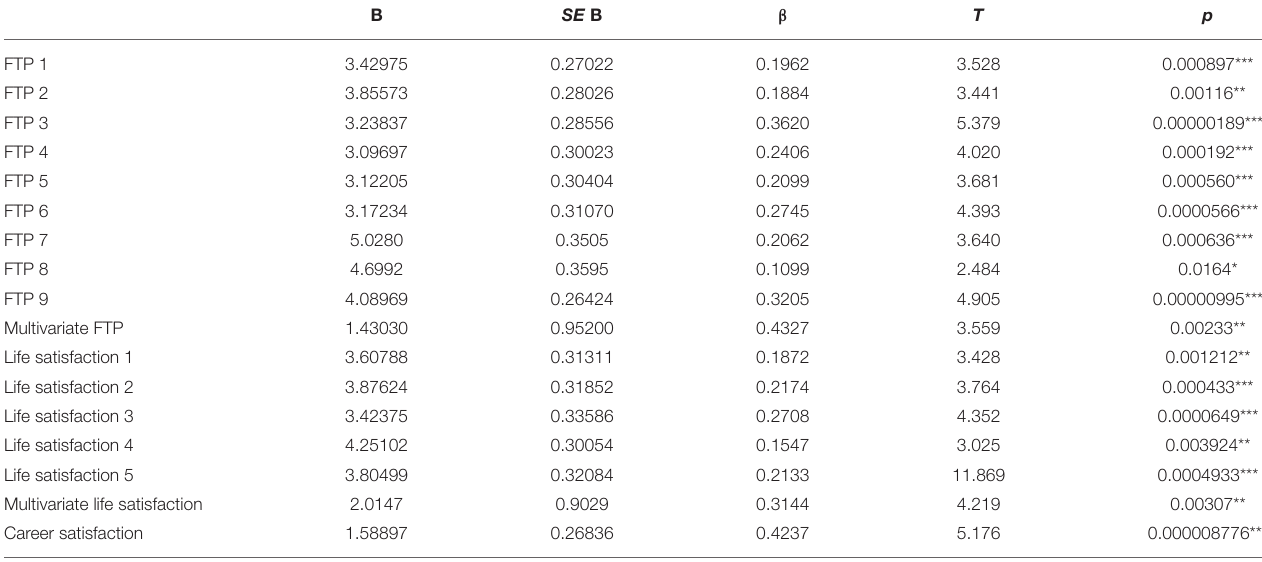
TABLE 2 | Logistic regression between the question “how many friends do you have?” and measures of future time perspective (FTP), life satisfaction, and career satisfaction.